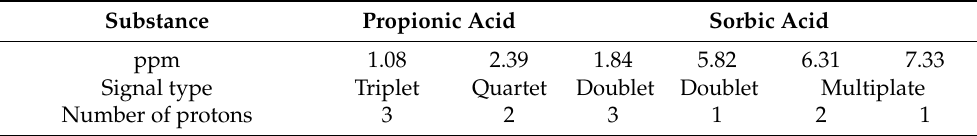
Table 4. Chemical shifts, signal type, and number of protons for NMR identification of sorbic and propionic acid.